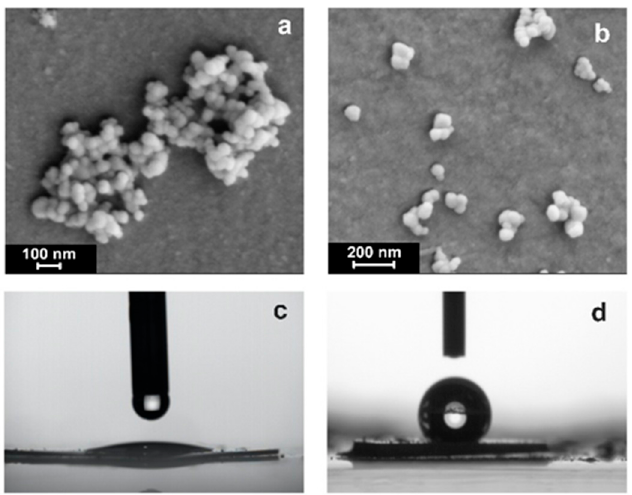
Figure 1. SEM and static water contact angle images of ZrO 2 nanoparticles before ( a and c ) and after surface fluorination ( b and d ), respectively.